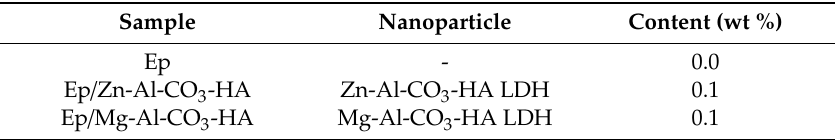
Table 1. Weight compositions of epoxy